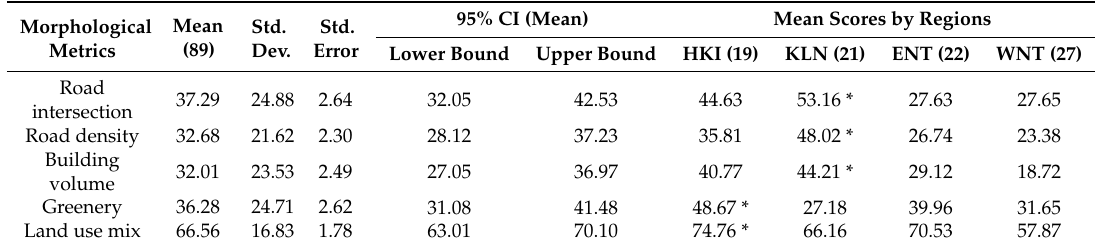
Table 1. Mean normalized scores of morphological metrics by geographic regions.